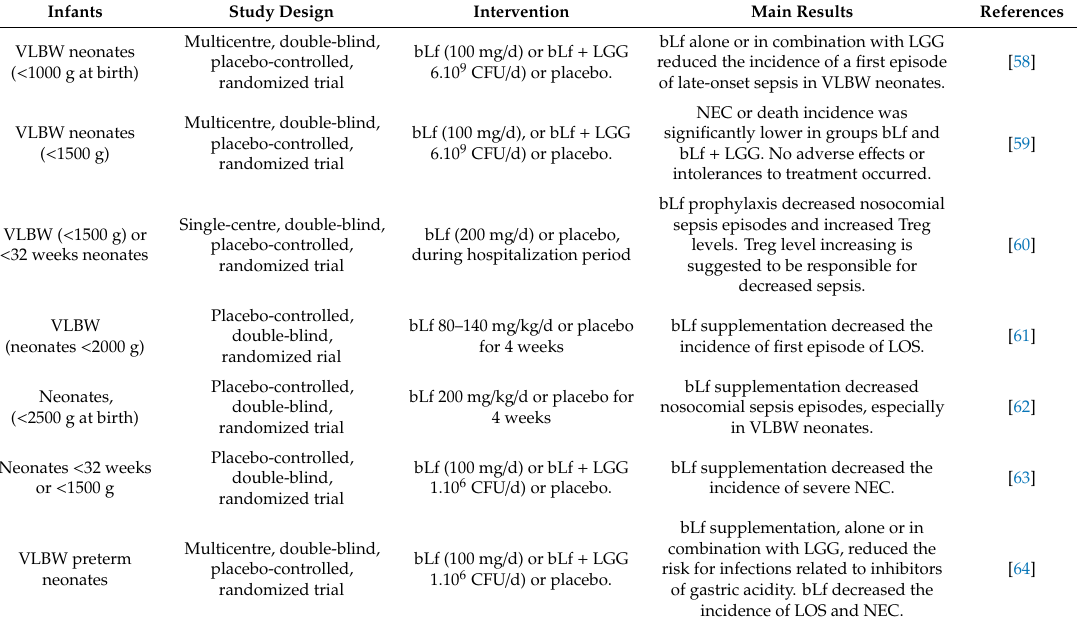
Table 1. E ff ect of bovine lactoferrin (bLf) in neonates: Clinical